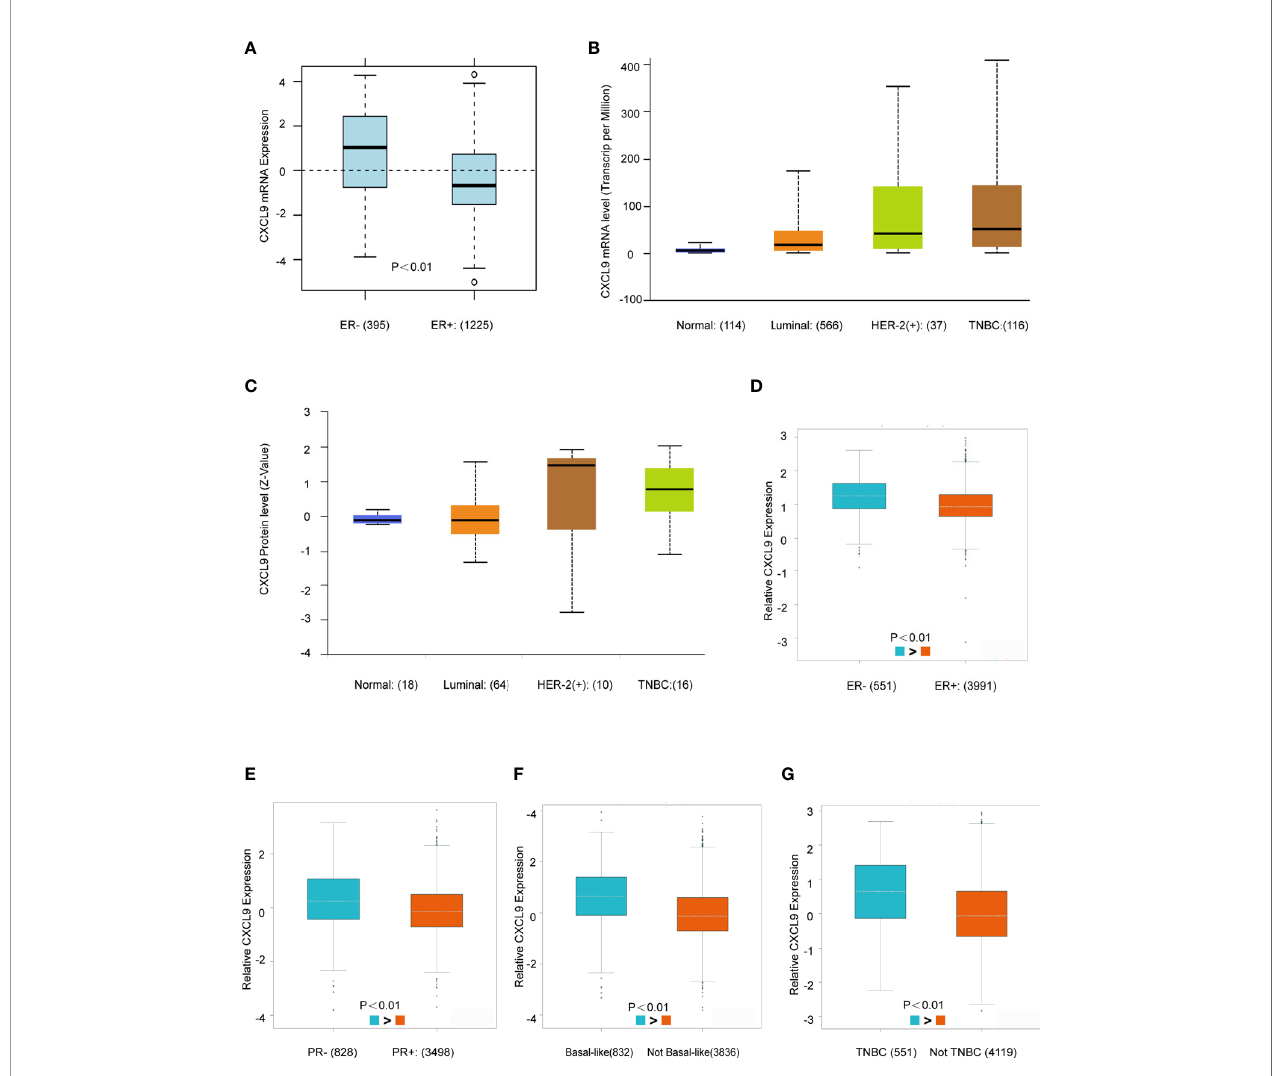
FIGURE 2 | CXCL9 was highly expressed in ER-, PR- and Basal-like subgroups of BC patients. (A) The mRNA expression level of CXCL9 in ER negative and ER positive breast cancer subgroups in GOBO database. (B, C) The mRNA expression and protein level of CXCL9 among different subtypes of BC in UALCAN database. (D – G) The mRNA expression level of CXCL9 in BC patients with ER negative and ER positive (D) , PR negative and PR positive (E) , basal-like and non- basal-like (F) , TNBC and non-TNBC (G) from bc-GenExMiner sub-group analysis. The t-test was used to estimate the signi fi cance of difference in gene expression levels between